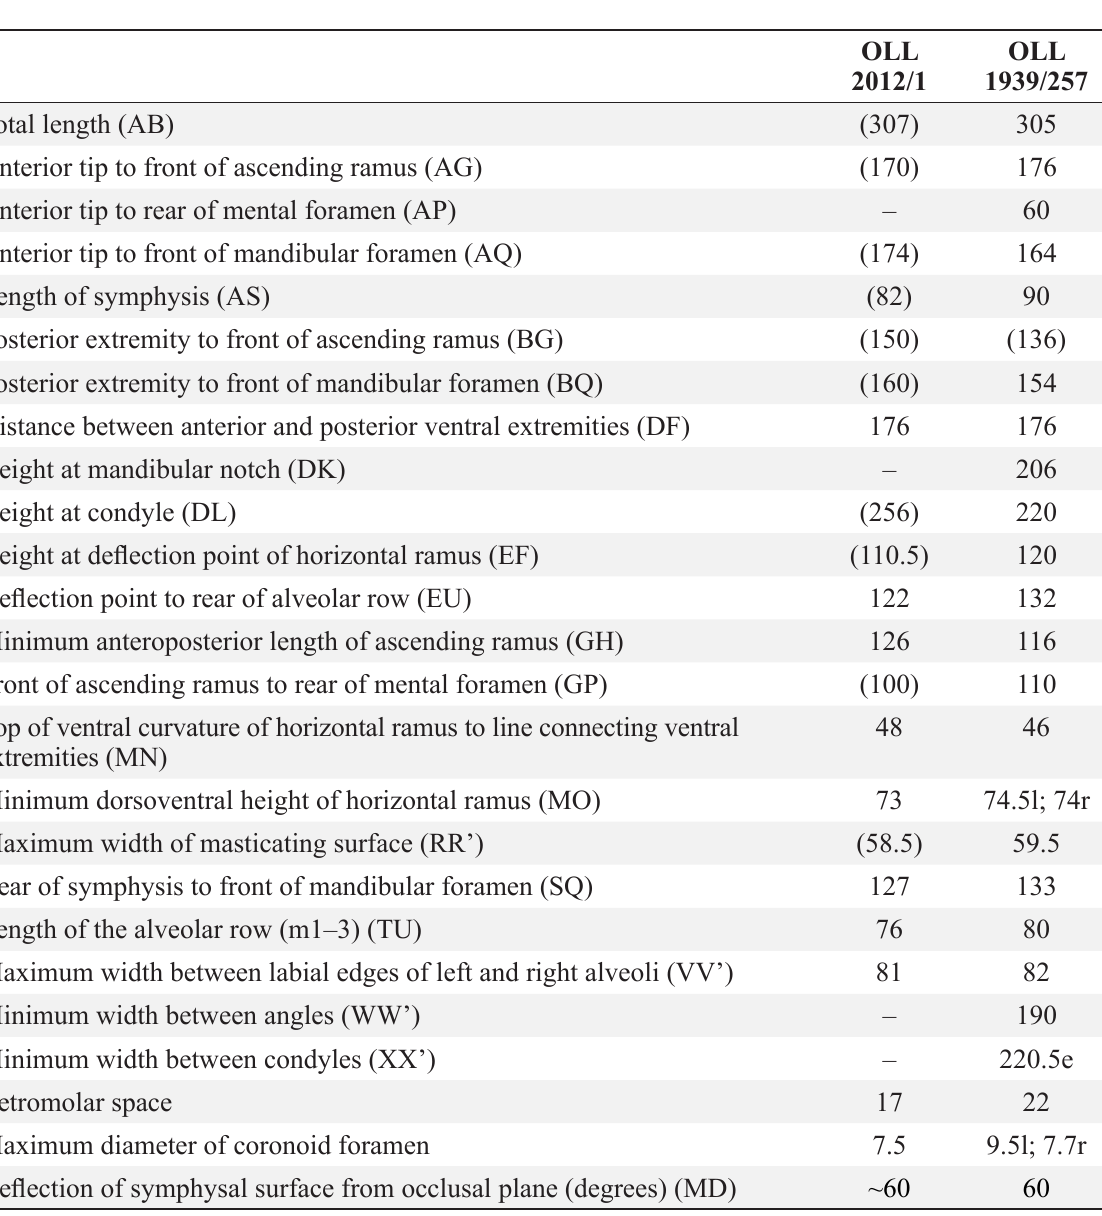
Table 3. Measurements (in mm, if not otherwise stated) of mandibles of Lentiarenium cristolii ( Fitzinger, 1842). Letters in parentheses denote the standard dimensions established by Domning (1978: table 7). Measurements in parentheses indicate preserved lengths, “e” estimated dimensions, “l” and “r” measurements from the left and/or right